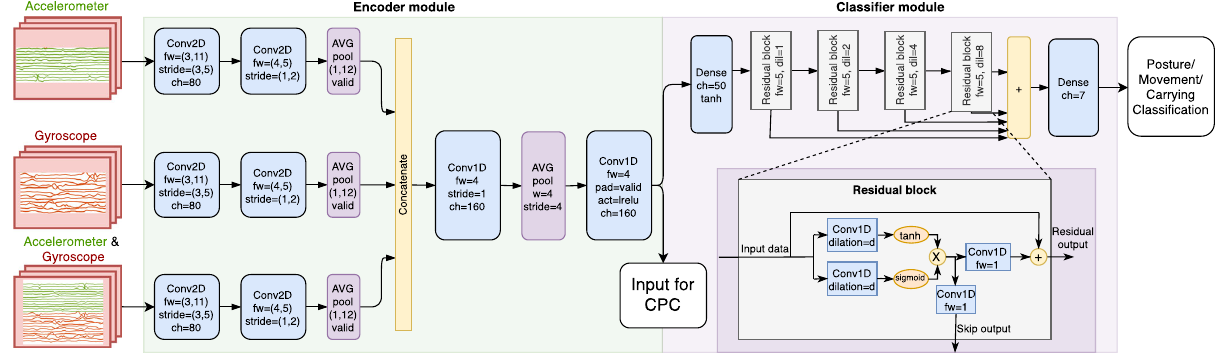
Fig. 3 Block diagram of the deep-learning-based motor ability classi fi er architecture. Abbreviations: activation function (act), average (AVG), channels (ch), convolution operation (conv), dilation (dil), fi lter size (fw), leaky recti fi ed linear unit (lrelu), padding (pad). The encoder module performs frame-level sensor fusion to obtain a 160-dimensional latent expression of the raw accelerometer and gyroscope signals. The classi fi er module models the frame-to- frame time dynamics of these features and outputs softmax probabilities for each category separately for each of the classi fi cation tracks (posture, movement, and carrying). The training was performed with minibatch gradient descent using the ADAM algorithm (batch size 100 consecutive frames, learning rate 10 − 4 , beta1 = 0.9, beta2 = 0.999, epsilon = 10 − 8 ) with a weighted categorical cross-entropy loss. In the loss function, each frame ’ s error was weighted with the inverse probability of the target class ’ s occurrence in the training data to mitigate the effects of unbalanced category distributions within the training data. Sample dropout ( p = 0.3), as well as sensor dropout ( p = 0.3), was also applied randomly to the input signals during training to ensure the robustness of the trained models. The training was run for 200 epochs and held out validation data (20% of training data) was used to select the best performing model in terms of the unweighted average F1 score. The code for the motor ability classi fi er was implemented with Tensor fl ow (v.1.12.0) and Python (v.3.6.9). The code is available at